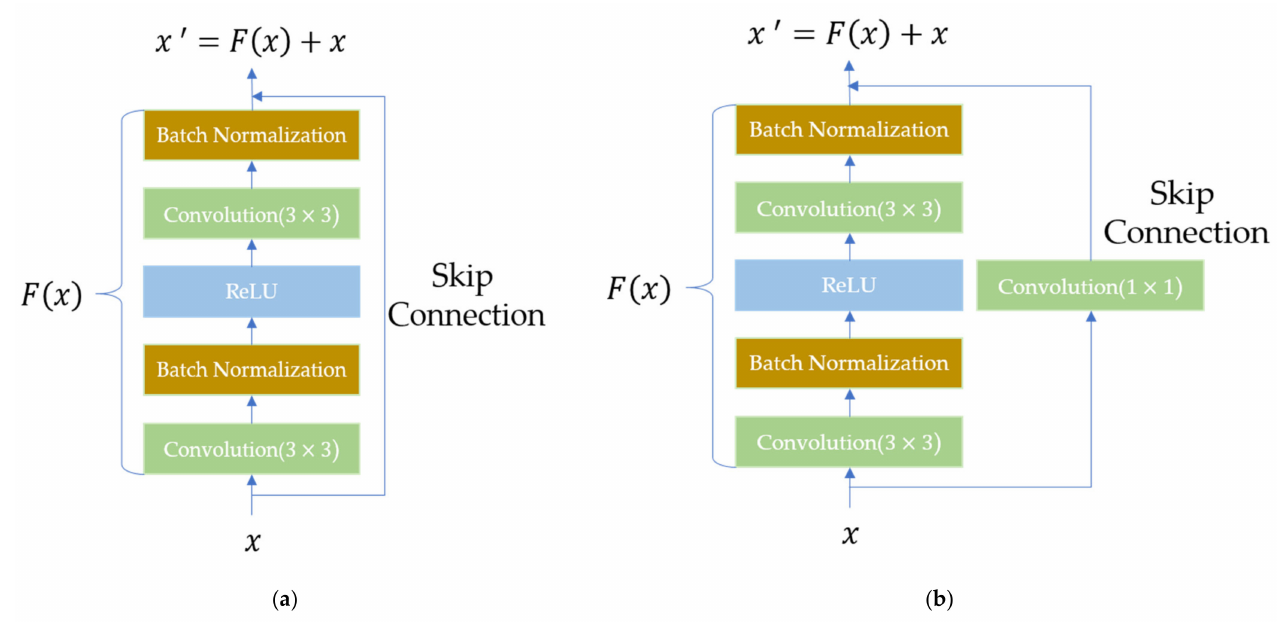
Figure 3. ResNet residual blocks ( a ) without and ( b ) with 1 × 1 convolution block.